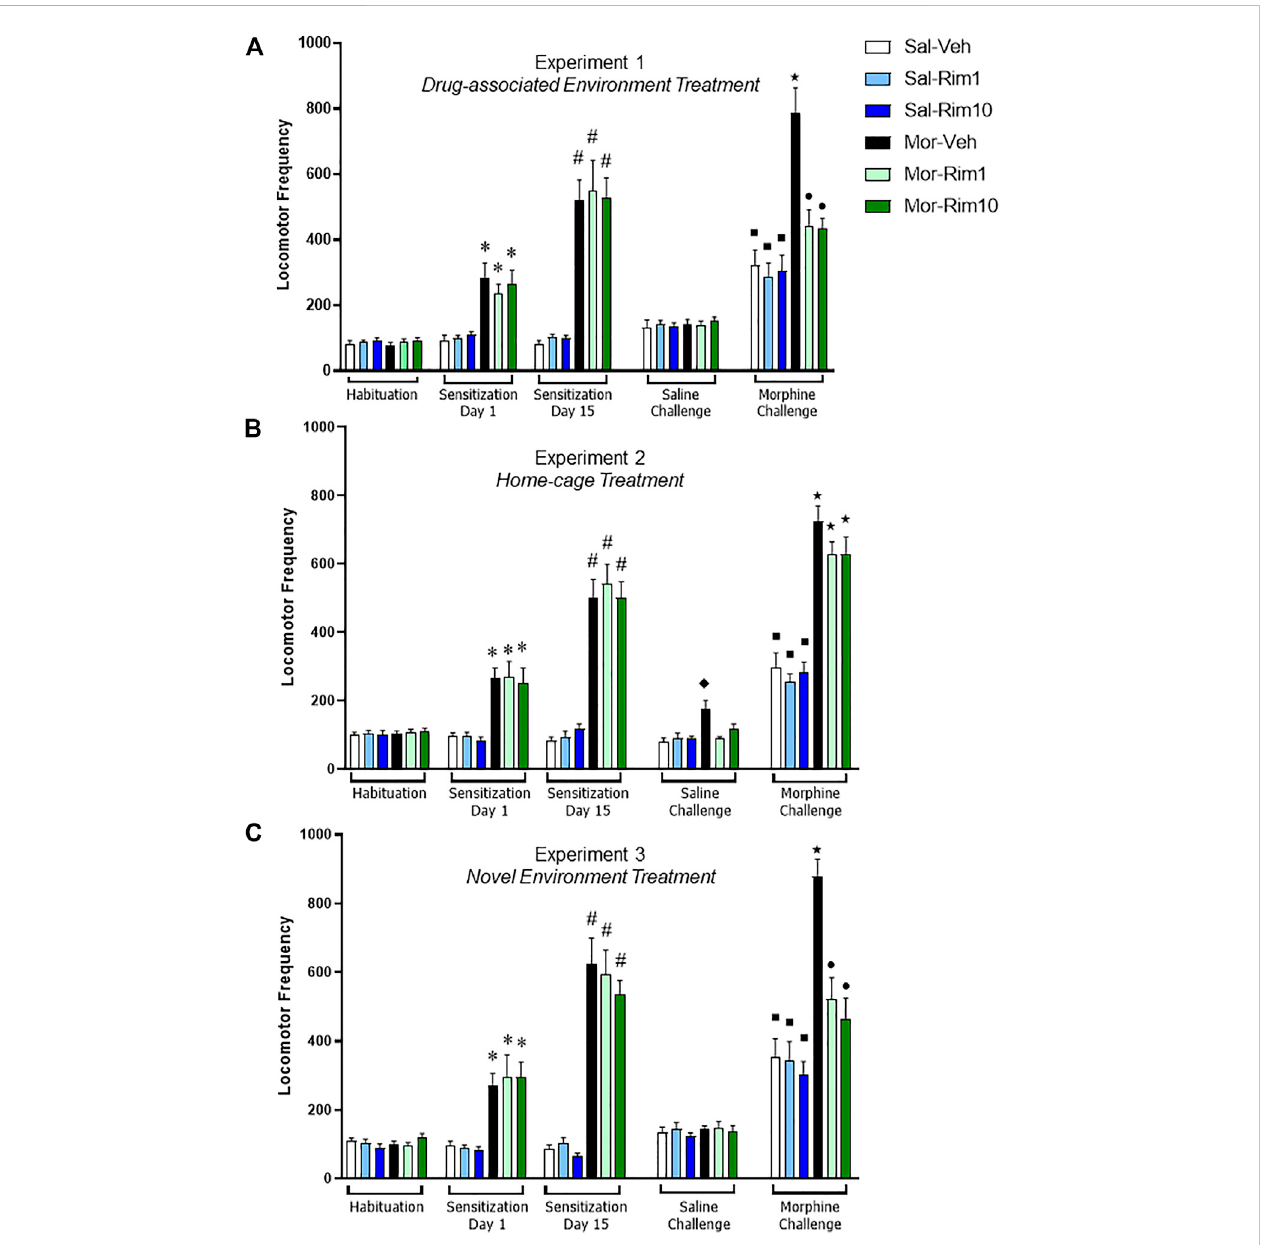
Open- fi eld locomotor activity quanti fi cation during the three behavioral experiments. Locomotor activity demonstrating acute hyperlocomotion induced by morphine (Mor, 20 mg/kg) (Sensitization Day 1) and morphine-induced behavioral sensitization (Sensitization Day 15) after a 15-day intermittent treatment (8 morphine or saline — Sal — injections). Effects of treatment with vehicle (Veh) or rimonabant (Rim1 and Rim10, 1 and 10 mg/kg, respectively) for 8 daysinthedrug-associatedenvironment[ (A) open- fi eld,Experiment1],inthehome-cage[ (B) Experiment2]orinanovelenvironment[ (C) activitybox, Experiment 3] on subsequent Saline and Morphine challenges. Data are reported as mean ± SEM. * p < 0.05 compared with Saline-treated groups on SensitizationDay1;# p < 0.05comparedwiththesamegrouponSensitizationDay1; ʋ p < 0.05comparedwiththeSal-VehgroupontheSalineChallenge; ■ p < 0.05 compared with the same group during the Saline Challenge; + p < 0.05 compared with the respective control group during the Morphine Challenge; C p < 0.05 compared with Mor-Veh group during the Morphine